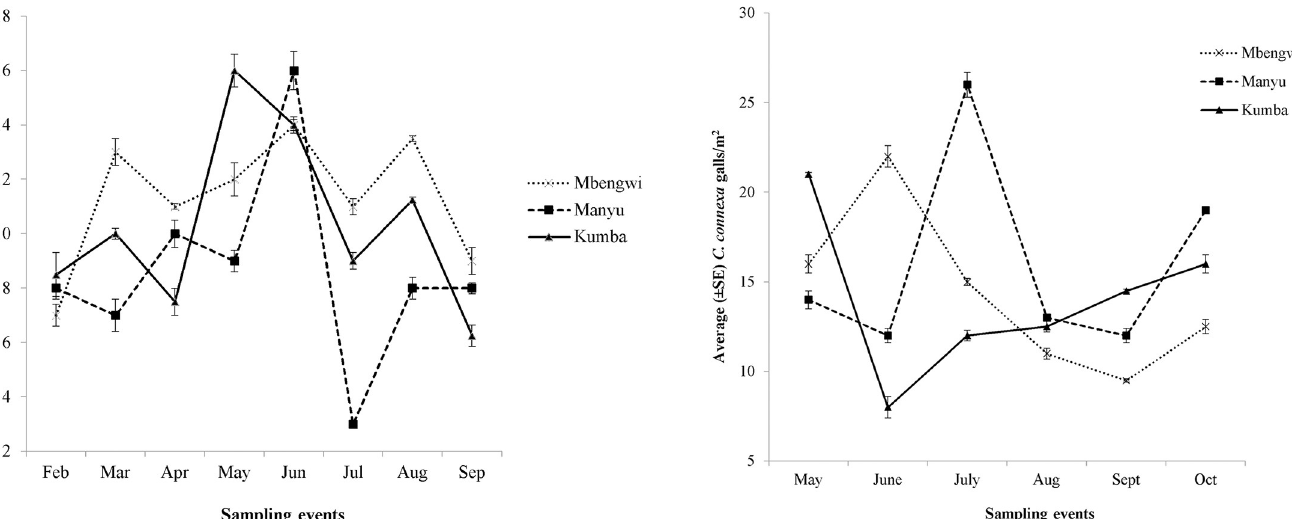
PLOS ONE | https://doi.org/10.1371/journal.pone.0252770 June 4,